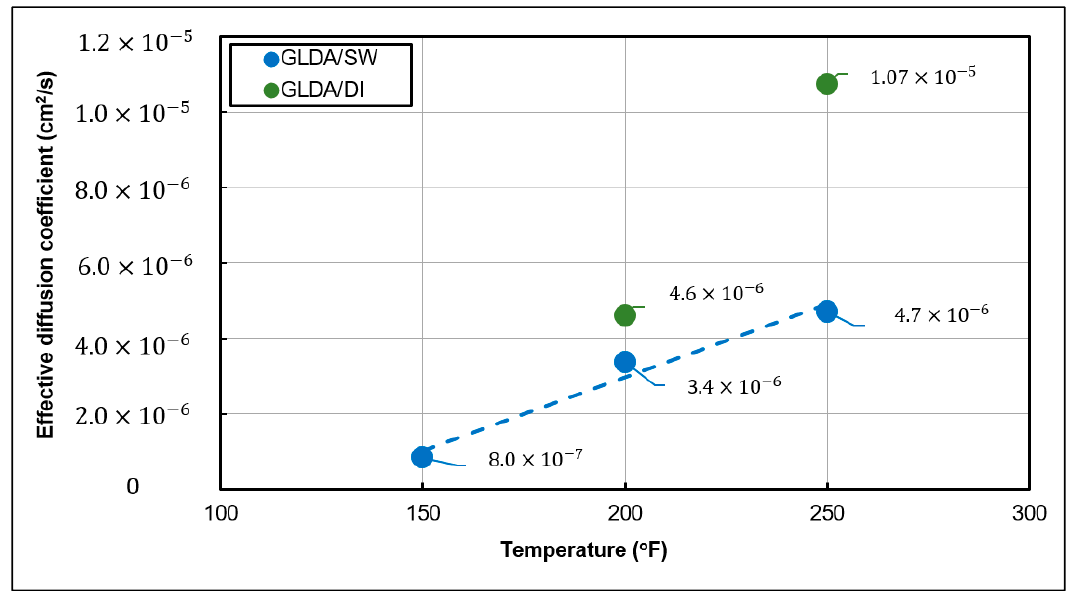
Figure 8. Diffusion coefficient of 20 wt% GLDA/DI and GLDA/SW as a function of temperature for Figure 8. Di ff usion coe ffi cient of 20 wt% GLDA / DI and GLDA / SW as a function of temperature for Indiana limestone. Indiana